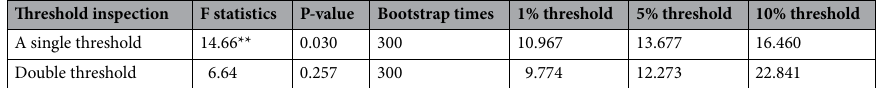
Table 4. Threshold effect test results. **indicate that the parameter estimation is significant at the levels of 0.01, 0.05, and 0.1.